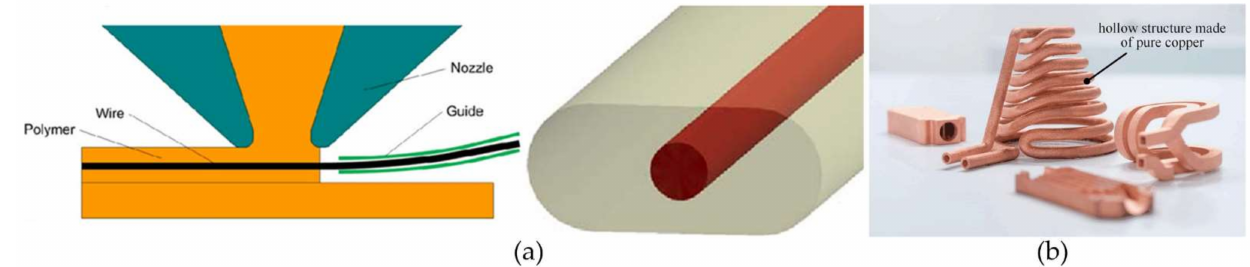
Figure 11. AM conductors: ( a ) Integration of wires inside the insulation using fiber encapsula- tion AM technique [34,35]. ( b ) 3D printed hollow conductors for the improvement of the cooling capability [36].